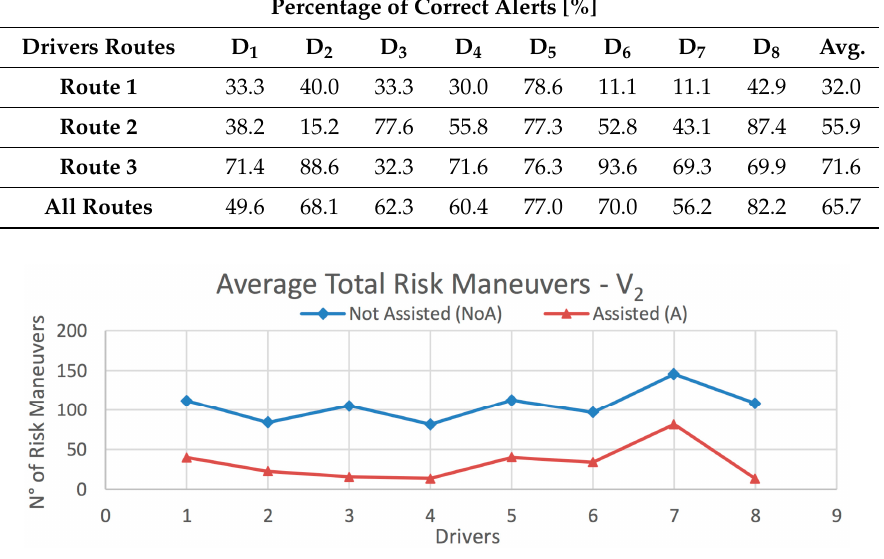
Figure 16. Average total risky maneuvers on all routes for V 2 ( Heavy Vehicle ). Table 7. Decrement percentage of risky maneuvers for V 2 (Heavy Vehicle): Route 1, Route 2, Route 3 and all routes.